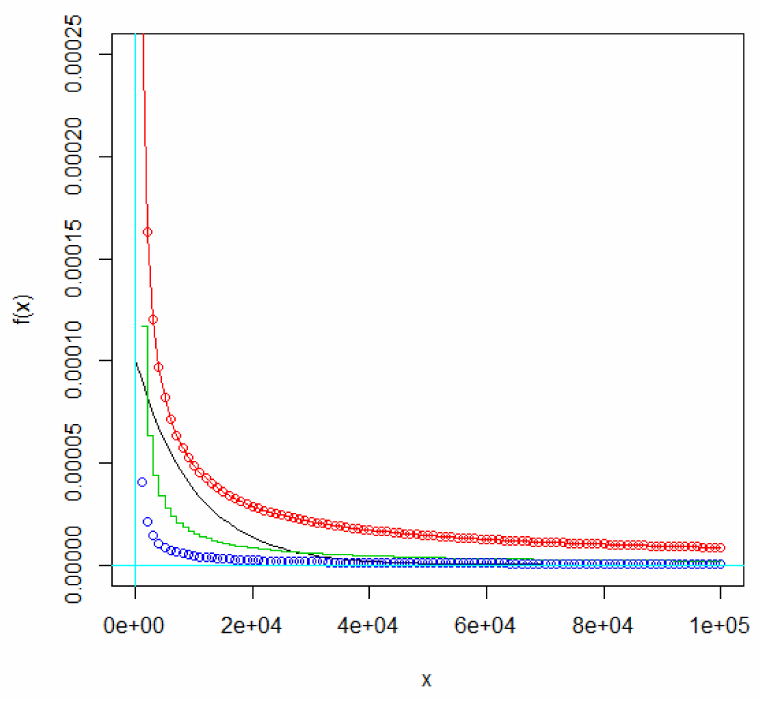
Figure 2. The PDF of the distribution gamma ( α , λ ) for different values of CV (blue: α = 0.04, λ = 0.001, CV = 5; green: α = 0.11, λ = 0.001, CV = 3; red: α = 0.25, λ = 0.001, CV = 2; black: α = 1, λ = 0.001, CV = 1).